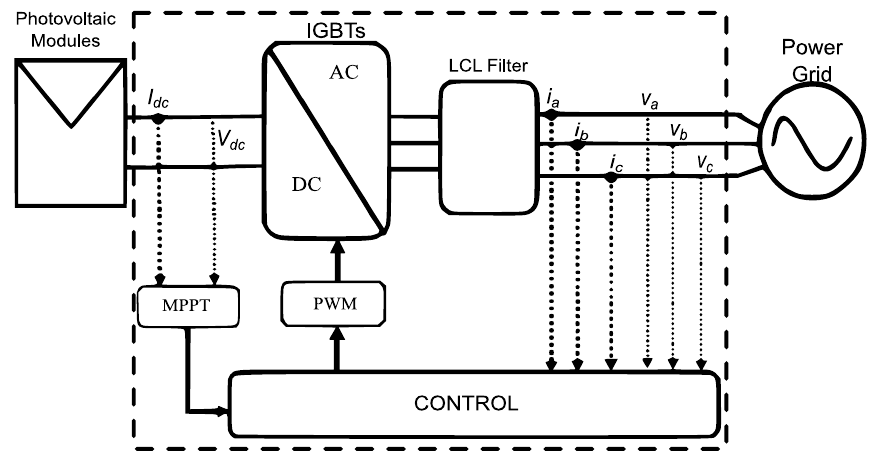
Figure 2. GCPVS under study.